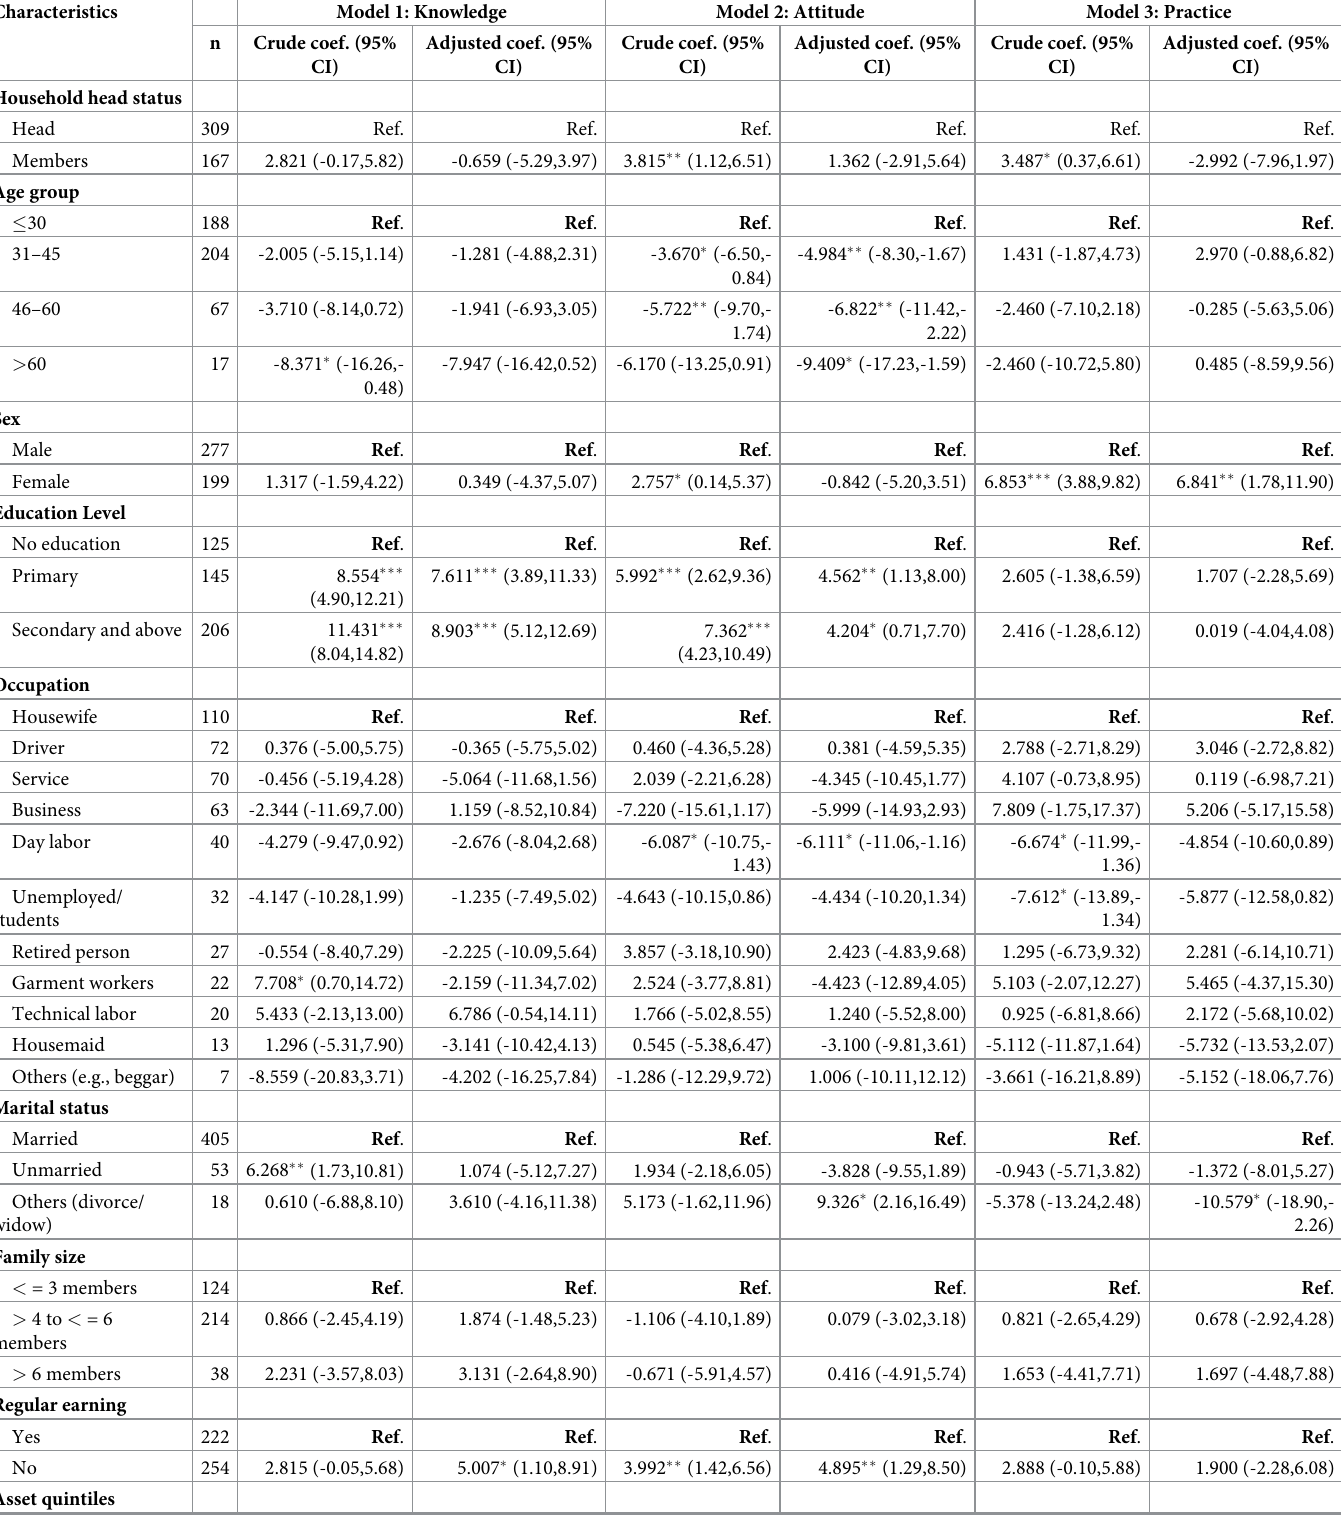
Table 6. Socioeconomic determinants of knowledge, attitude, and practice towards COVOD-19.